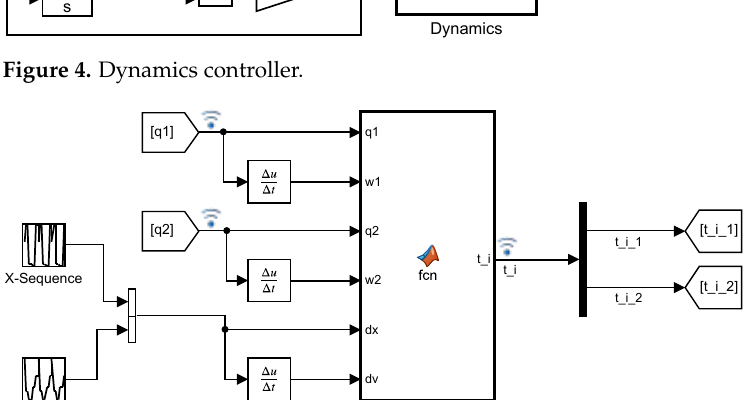
Figure 4. Dynamics controller.